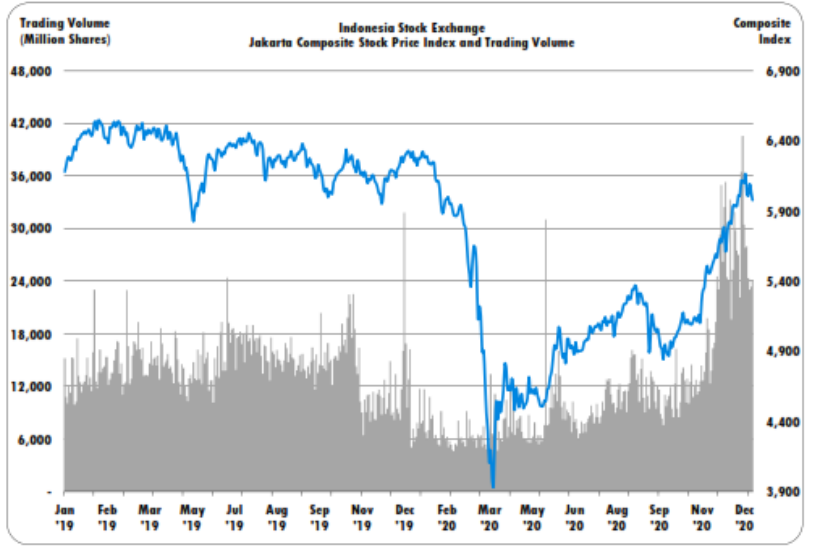
Fig. 1. Jakarta Composite Price Index and Trading Volume (Jan 2019 – Dec 2020) Source: